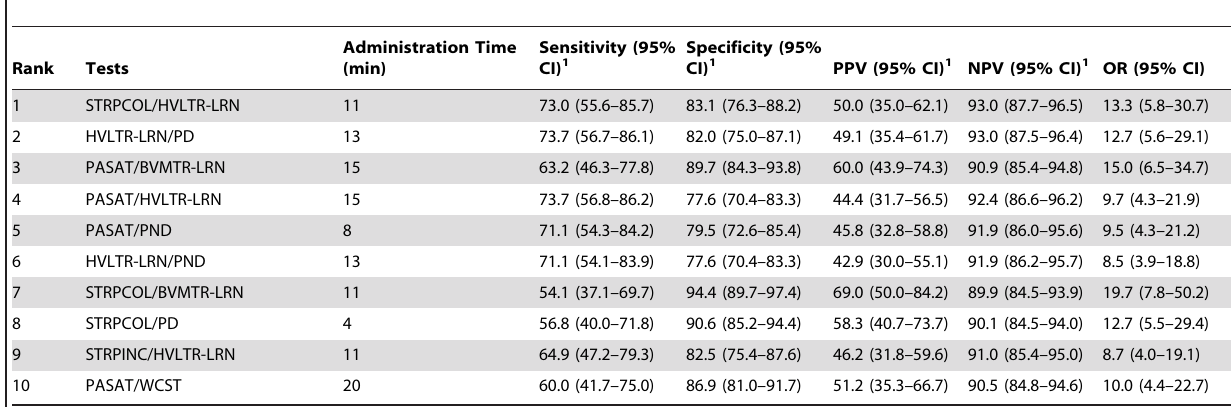
Table 2. Top 10 2-test combinations, ranked according to sum of sensitivity and specificity compared to a 120 minute global neuropsychological battery.